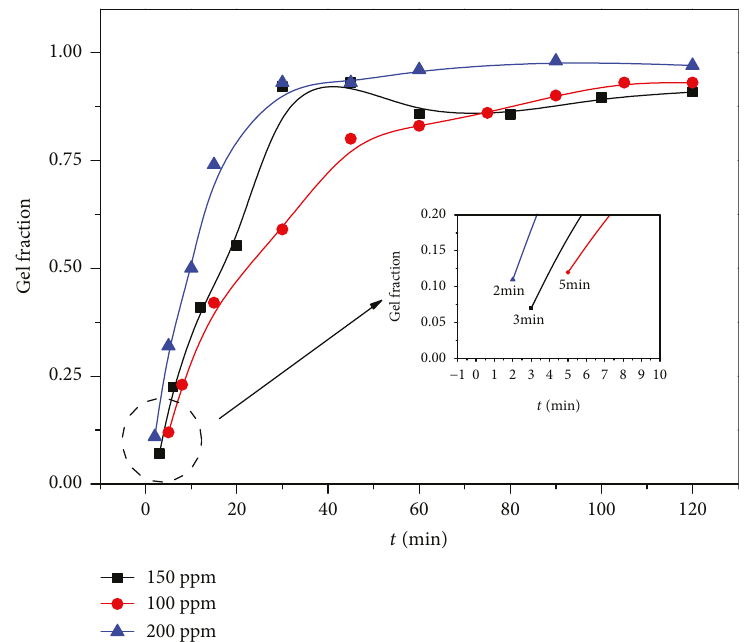
Figure 9: Gel time with di ff erent TEA content at 105 °